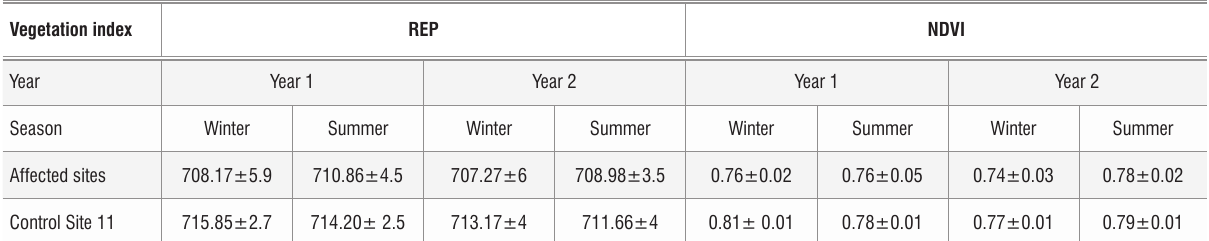
Means and standard deviations for red edge position (REP) and normalised difference vegetation index (NDVI) values for sites affected by acid mine drainage and an unaffected control site, in winter and summer over 2 years Vegetation index